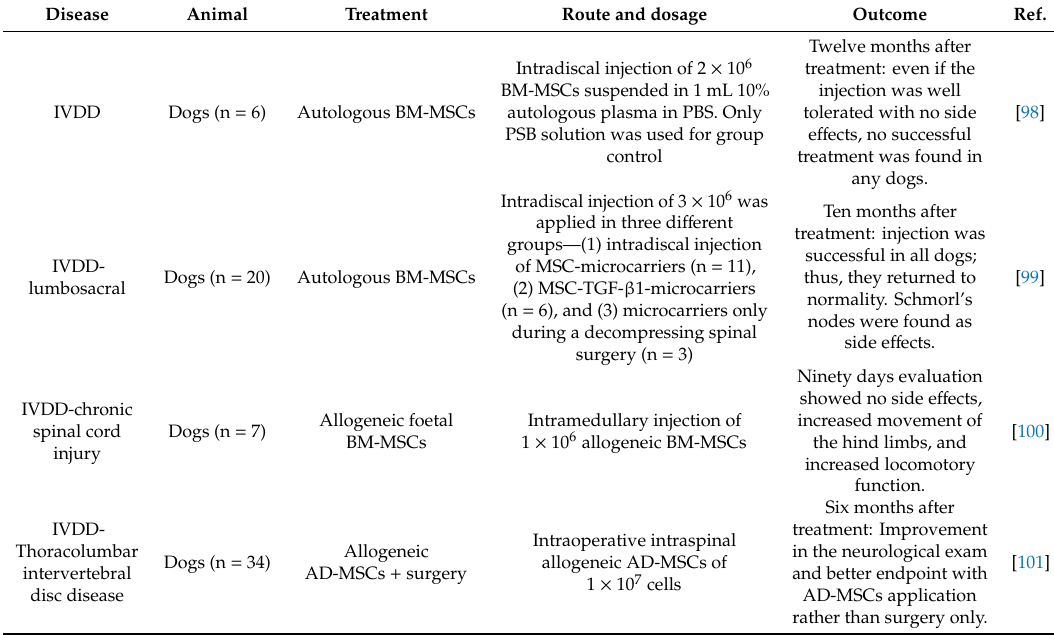
Table 4. Summary of intervertebral disk degeneration (IVDD) disorders treated with MSCs.